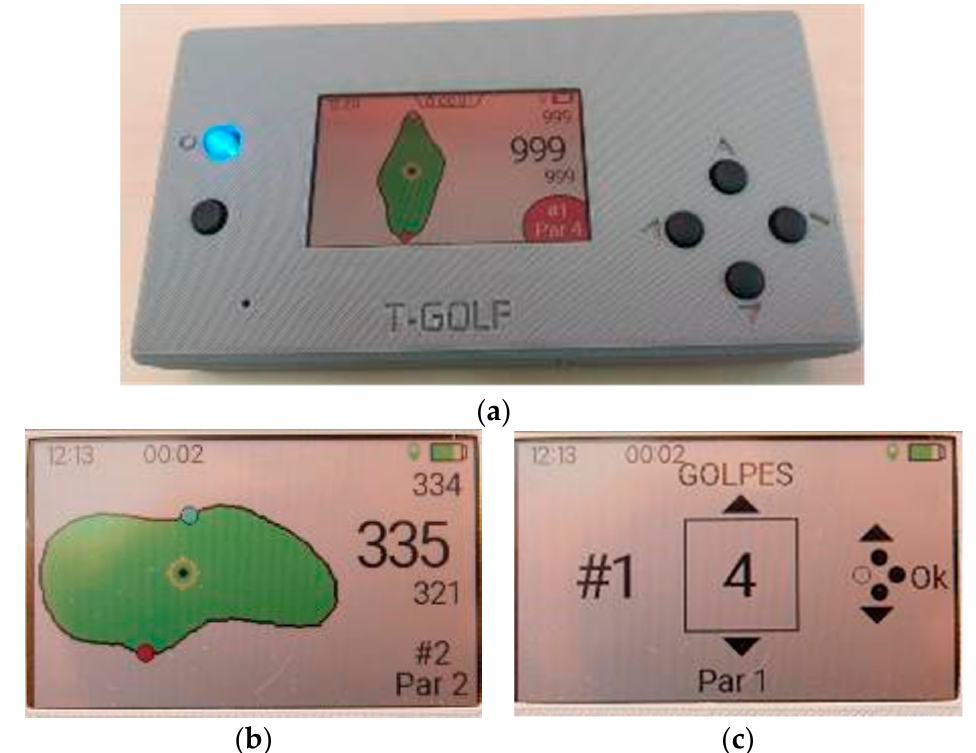
Figure 18. ( a ) USER-ED showing the map of a hole; ( b ) Screenshot of a hole map with info regarding distance to the green, hole number and PAR of the hole, among others; ( c ) Screenshot of the application to introduce the number of made strokes.